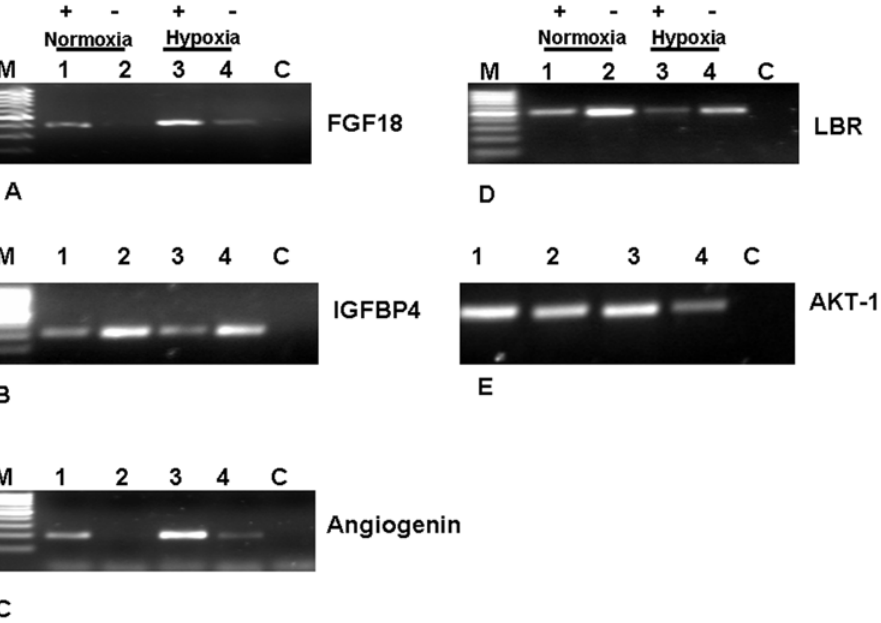
Figure 8. Expression levels of selected genes in Hep3B cells transfected either with H19 and GFP siRNAs under normoxic and hypoxic conditions. A few genes that showed variations as a result of H19 knockdown under different manipulations were selected, based on their potential importance in tumorigenesis, for further RT-PCR analysis to confirm the results of the microarray data. In the figure + denotes ( + H19) and –(-H19). The genes chosen were (A)-FGF18; (B)-IGFBP4; (C)-ANG; (D)-LBR; and (E)-AKT1 . The knockdown, of H19 and the RT-PCR integrity are shown in Figure 7.